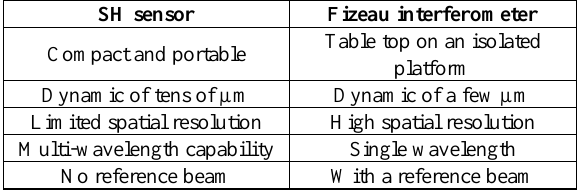
sensor and Fizeau